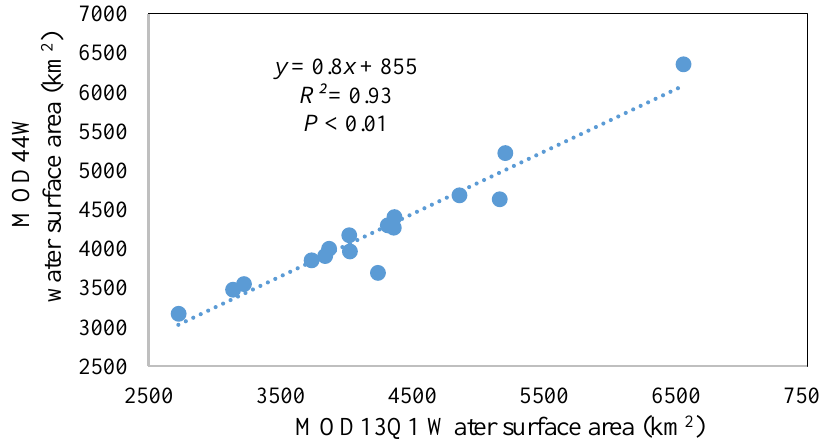
Figure 2. Water surface area correlation diagram obtained from MOD44W and MOD13Q1 data.